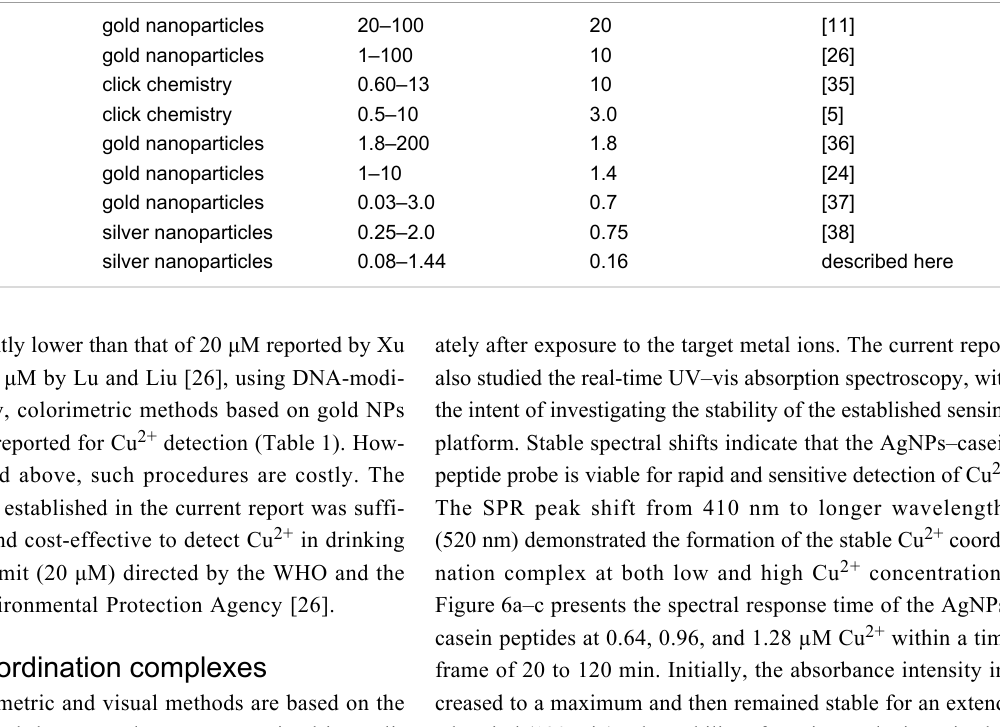
Table 1: Detection limit of Cu 2+ reported using various colorimetric methods and surface chemistries.